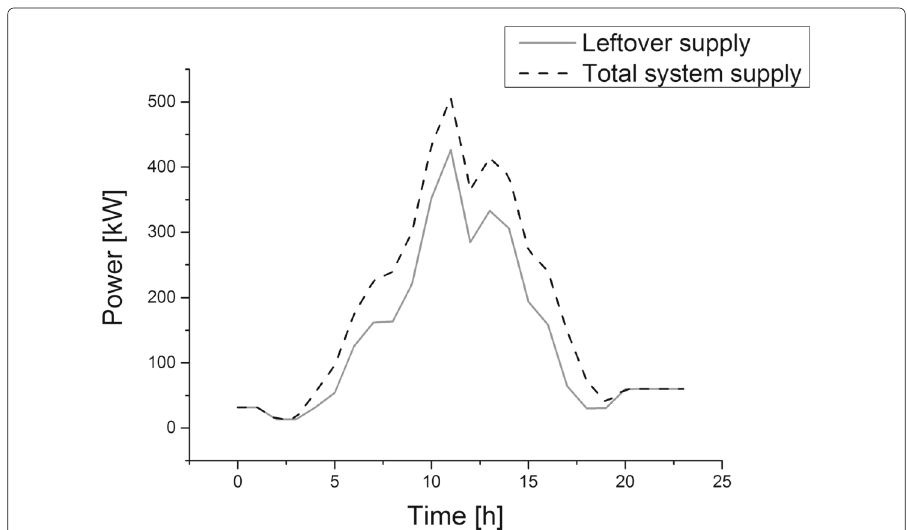
Fig. 9 Total supply in the system and leftover supply (after self-consumption by prosumers) - Wind and solar